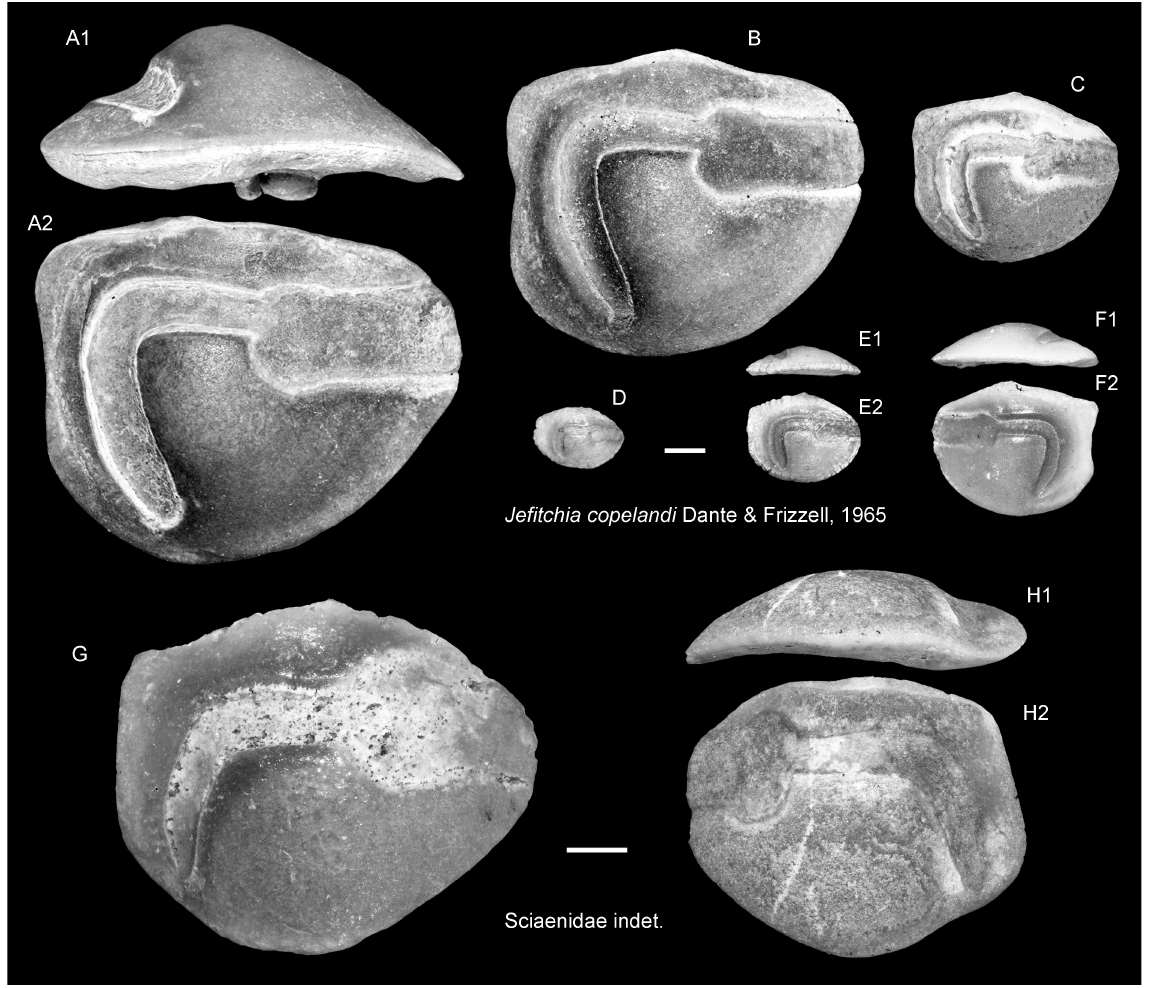
Fig. 33. Fish otoliths from the US middle and upper Eocene. A–F . Jefitchia copelandi Dante & Frizzell, 1965. A–B . Wheelock M., Little Brazos River, confluence with Brazos River, Texas (IRSNB P 10217– 10218). C–F . “Stone City beds”, Stone City Bluff, Brazos River, sample 6 from bed U, Texas (IRSNB P 10219–10222). G–H . Sciaenidae indet. G . Gosport Sand, Claiborne Bluff, Alabama (IRSNB P 10223). H . Potterchitto M., Newton, NE exit off Interstate 20, Mississippi (IRSNB P 10224). 1 = ventral view; 2 = inner view. Scale bars = 1